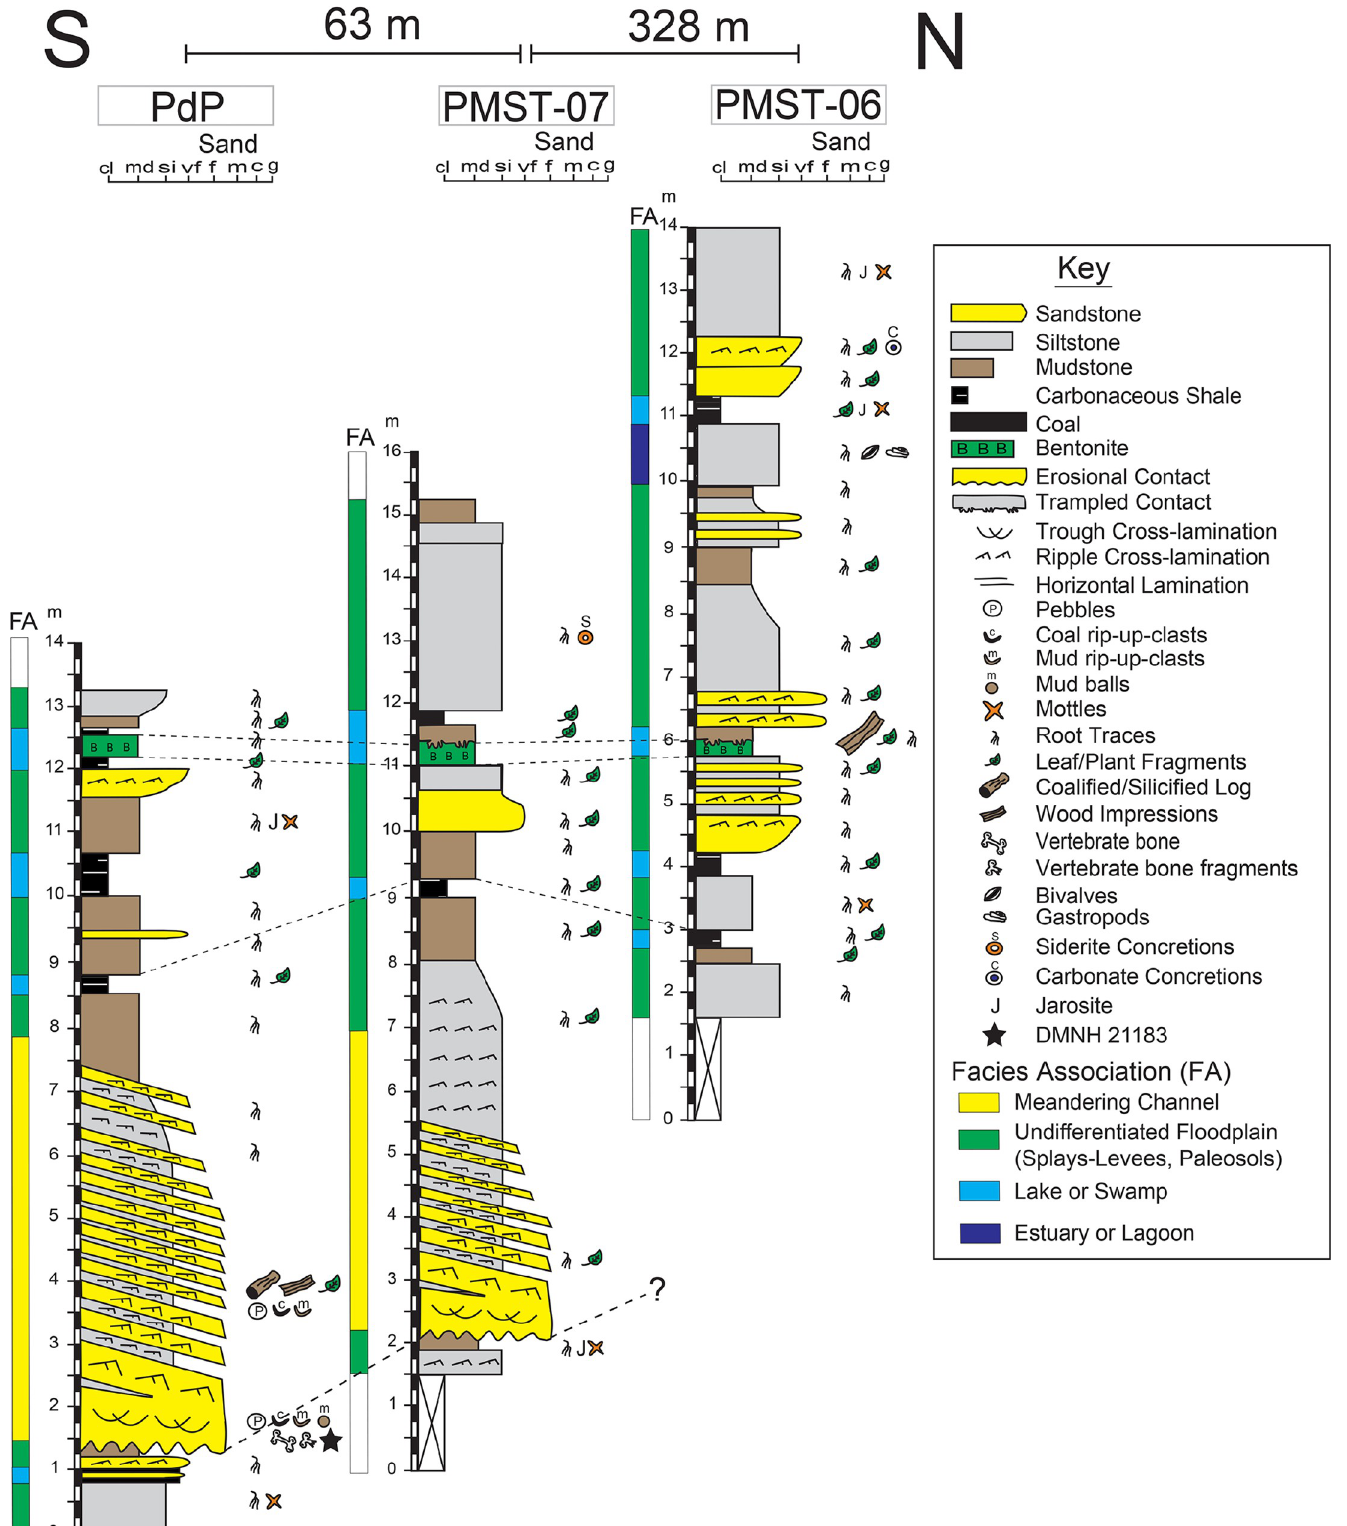
Fig 2. Geological setting. Stratigraphic sections at Pediomys point. Black star represents DMNH 21183.